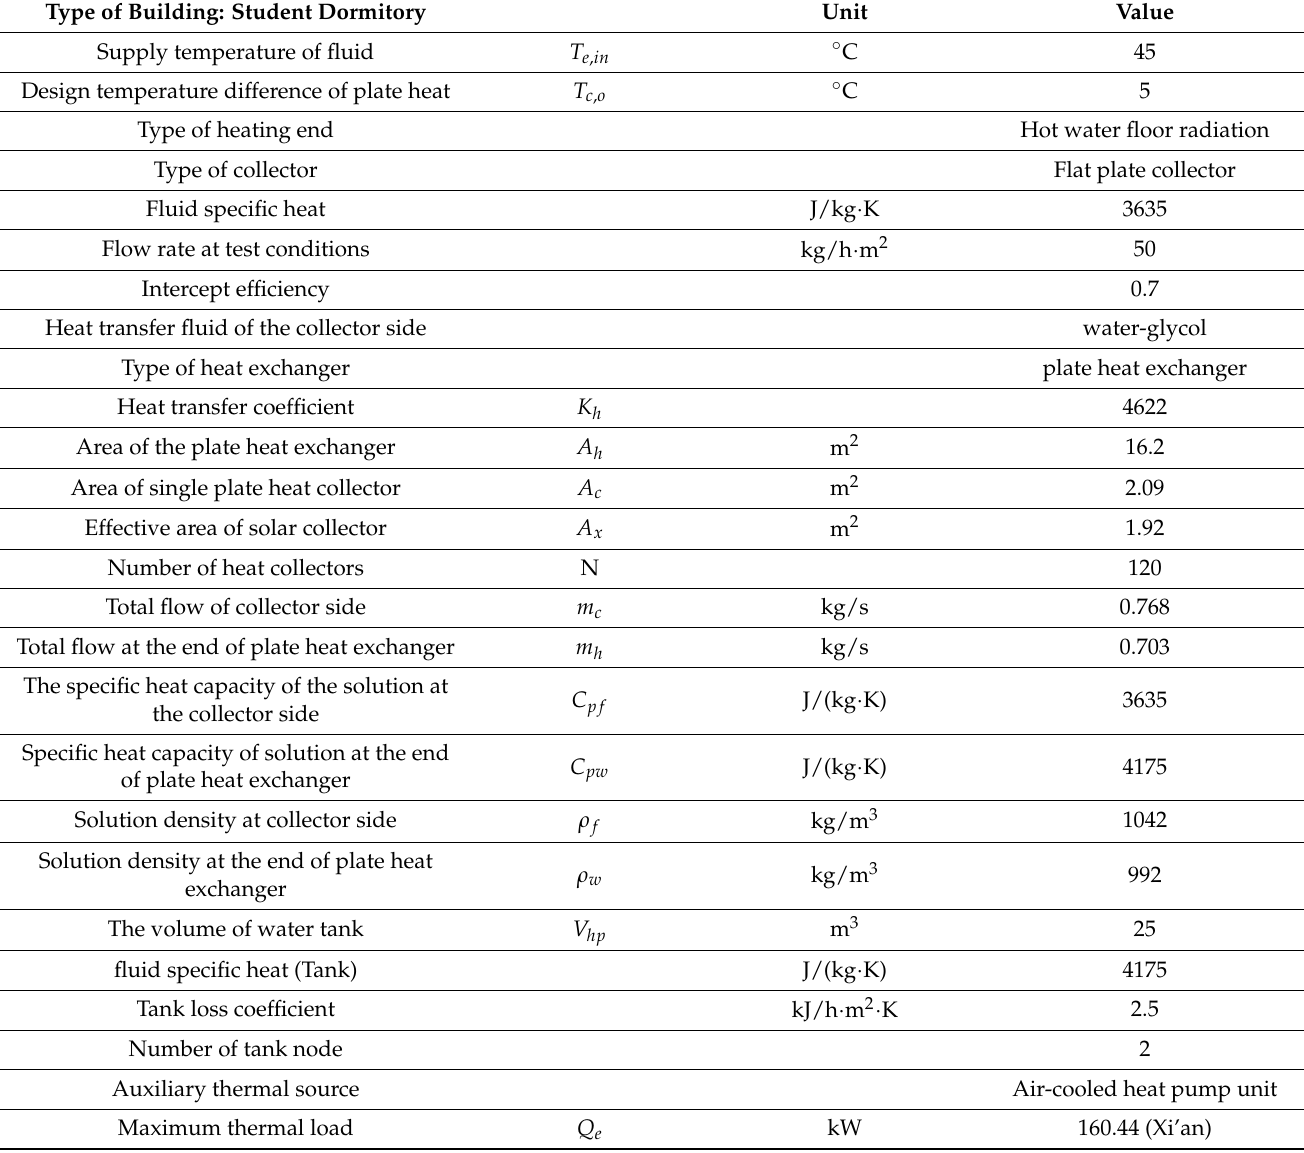
Table 2. SHS Parameter calculation table of the dormitory